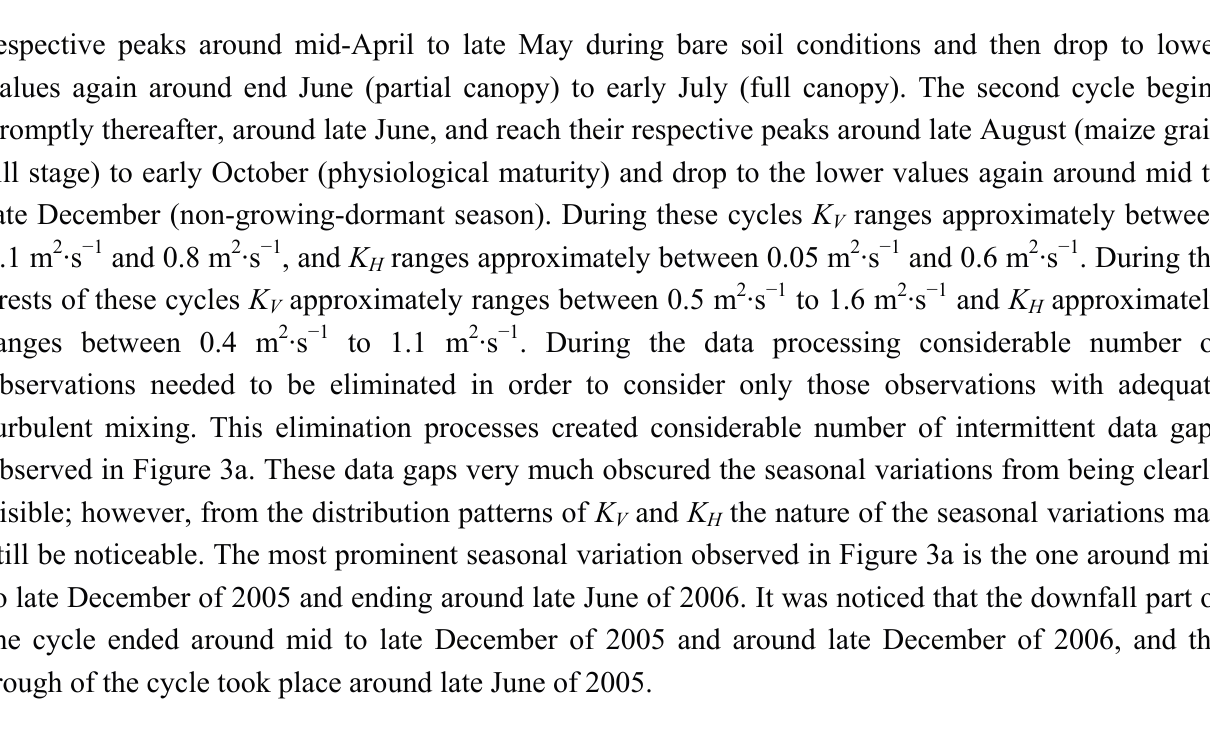
against K for growing and non-growing (dormant) H V